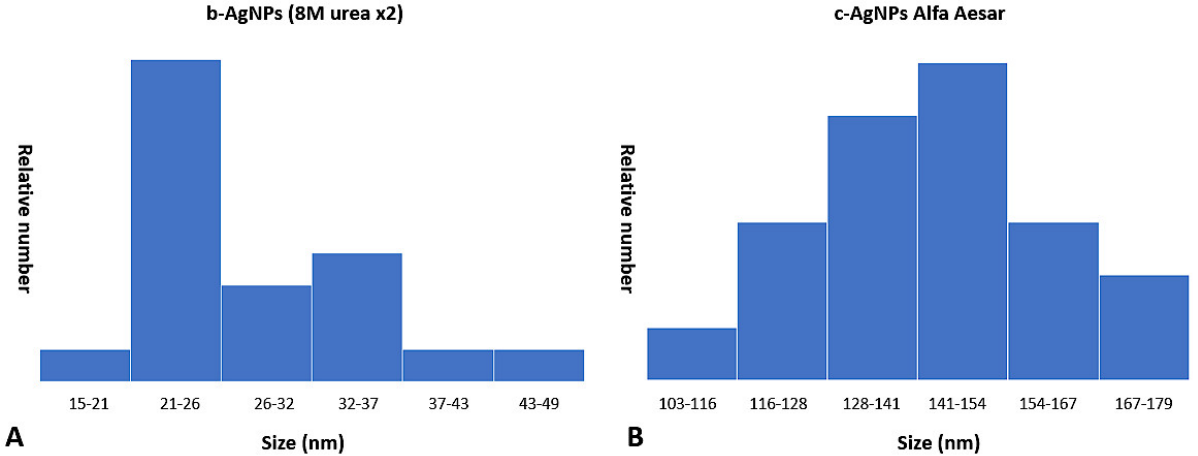
Figure 6. Histograms. Panel ( A ) shows the size distribution of b-AgNPs treated twice with 8M urea while panel ( B ) shows Alfa Aesar c-AgNPs (TEM